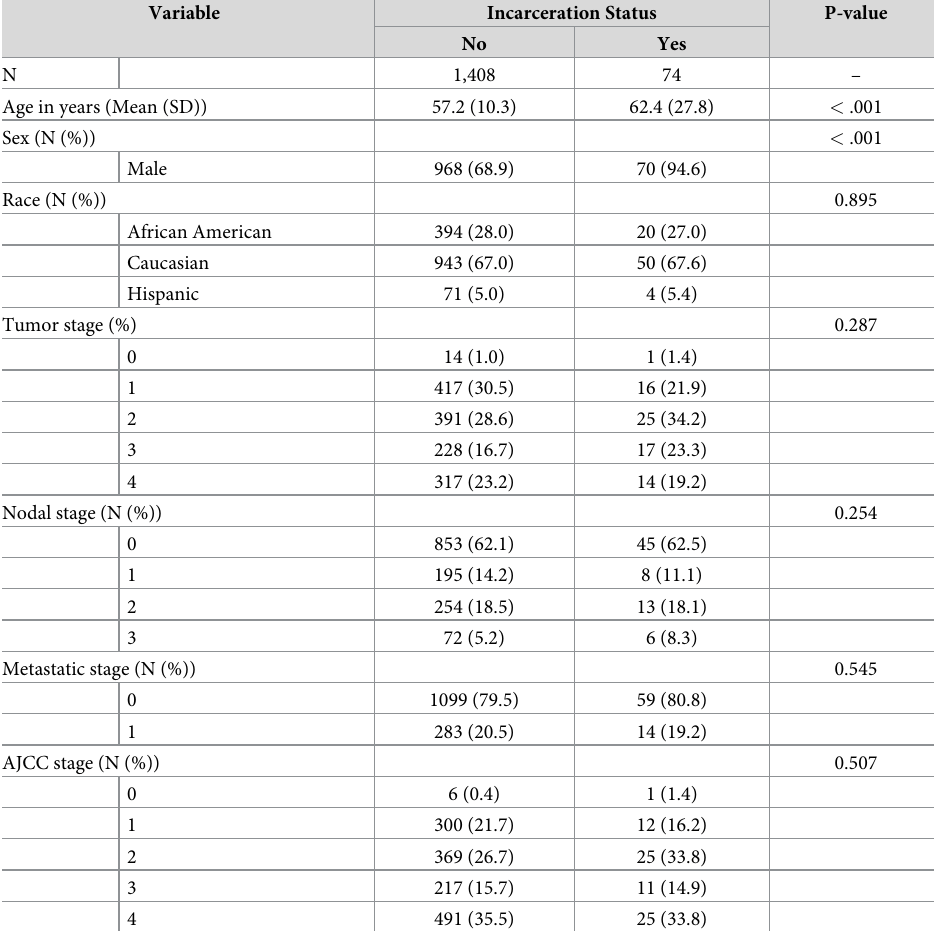
Table 1. Summary demographics for patients included in